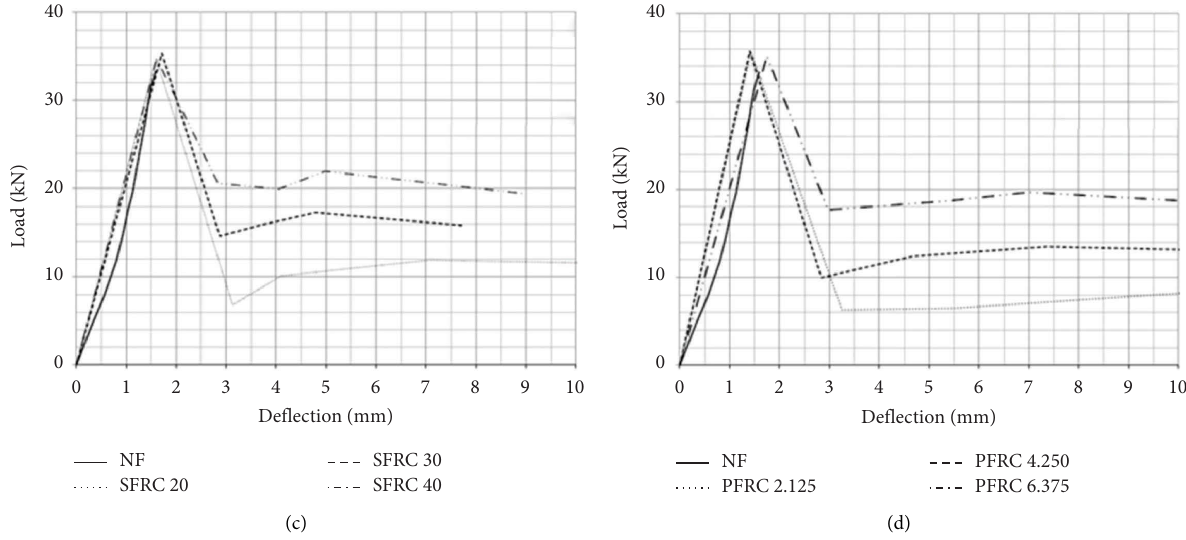
Figure 8: Compression and defection load curves in DRAMIX and EUCLID fbers.